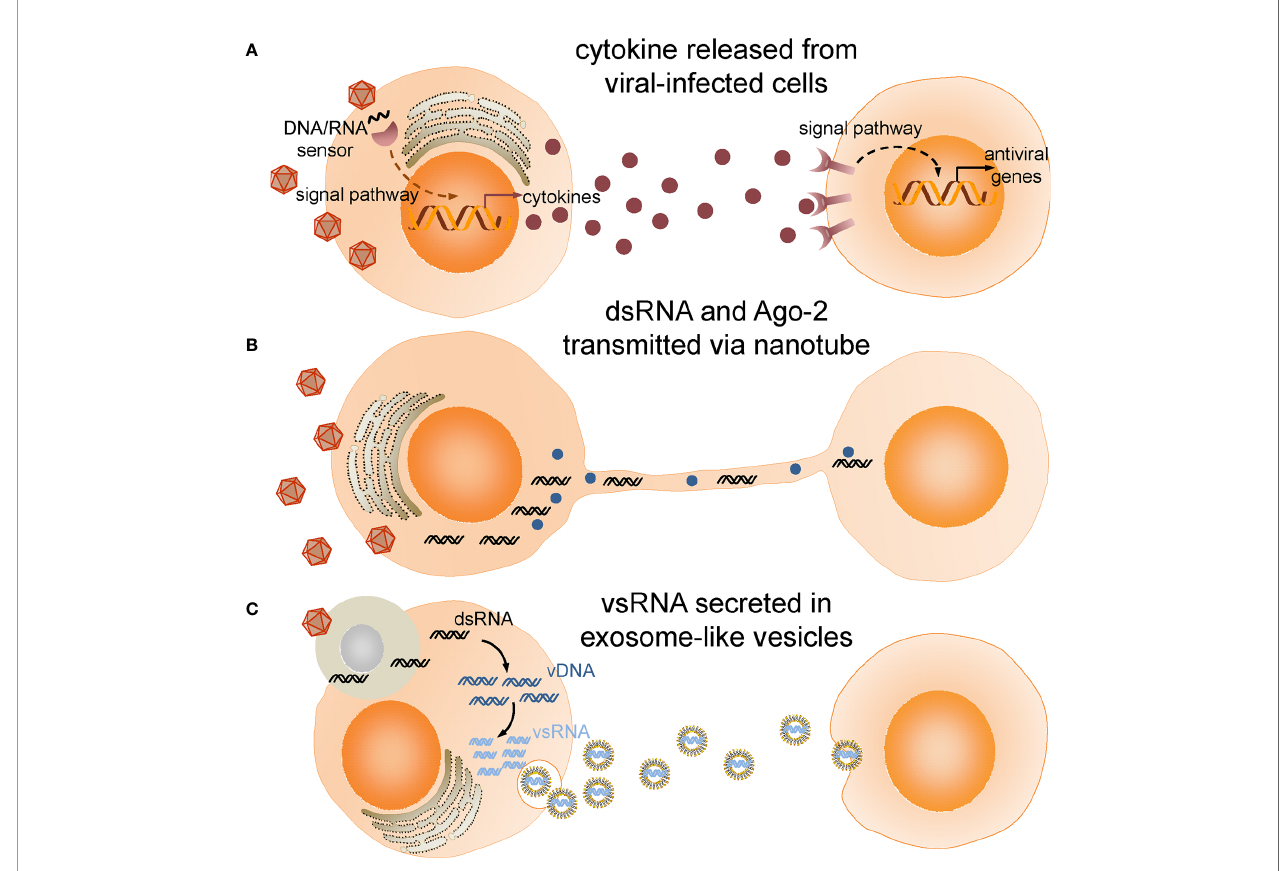
FIGURE 1 | Intercellular communications in insect antiviral immune response. (A) Cytokines produced and released from viral infected cells bind to receptors and activate antiviral immune response in target cells. (B) Double-stranded RNA (dsRNA) and Ago-2 is transferred through tunneling nanotubes bridging infected cells and neighboring cells. (C) Viral-derived dsRNAs (vsRNAs) produced in viral-infected cells engulfed by haemocytes are reverse-transcribed into vDNAs by endogenous transposon reverse transcriptase. vDNAs then serve as template for transcription of secondary vsRNAs which are secreted in exosome-like vesicles and processed into siRNA by cells taking up these